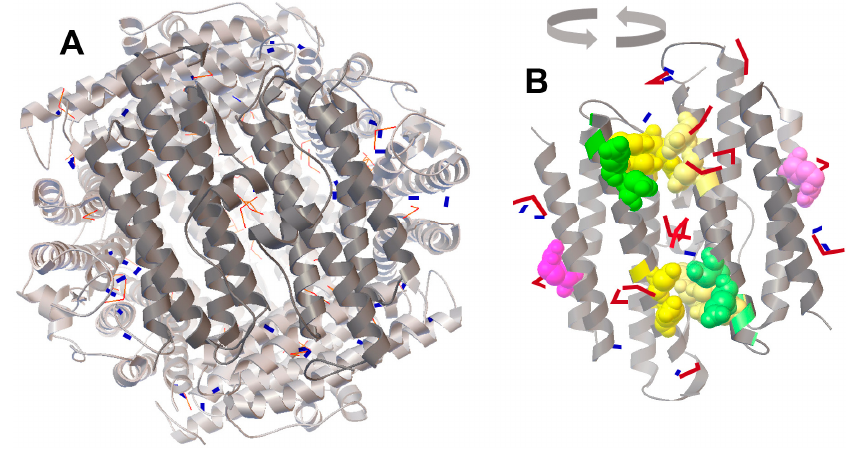
Figure 3. The positioning of FeO (blue rectangles) and Fe 2 O 3 (red bent models) shown on the surface of dodecamer ( A ) and dimer ( B ). Accession code of the 3D model in the PDB: 1 dps [5]. Locations of Fe 2 O 3 are accented in ( B ). The docking was performed independently for 50 molecules of FeO and Fe 2 O 3 , and two patterns of positional coordinates were superimposed on the 3D structural model of Dps (left panel). To show the distribution of iron oxides near the ferroxidase centers, two adjacent subunits (dark gray) were rotated for 180° (right panel). Yellow and green spheres show amino acids of ferroxidase and nucleation centers, respectively. Important for the integrity of Dps, R133 [30] is indicated in violet. The 3D structure of the Dps protein was visualized by RasMol 2.7.5 [31].